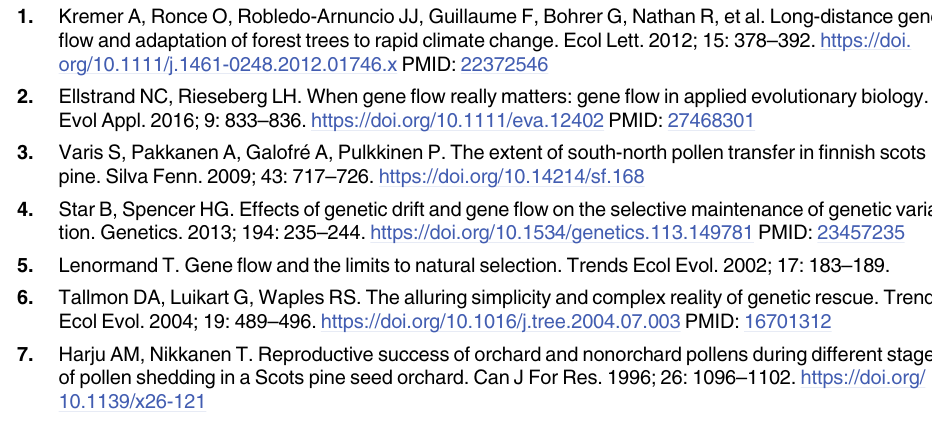
S1 Table. Observed haplotype counts and assumed frequencies for simulations. S2 Table. Expected errors of gene flow rate